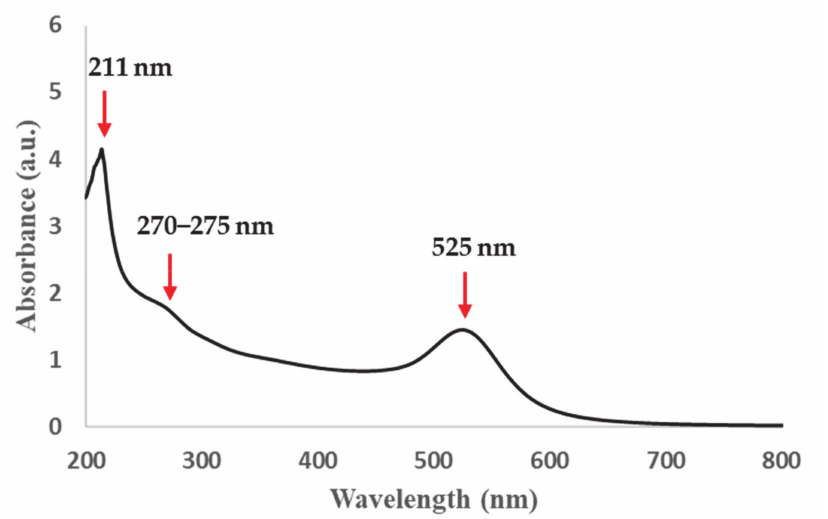
Figure 2. UV–Vis absorbance spectra of SA-Au NPs showing the SPR band at 525